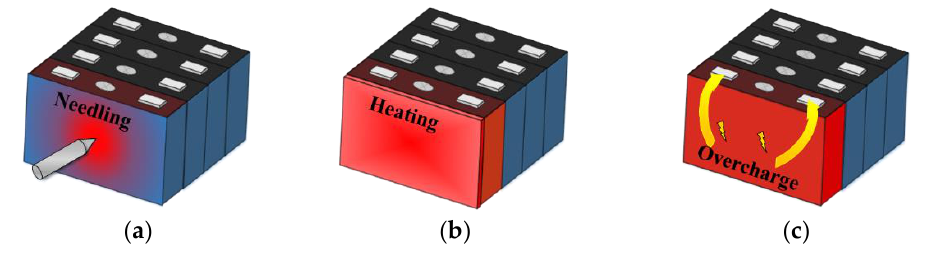
Figure 3. Trigger methods: ( a ) needling; ( b ) heating; ( c ) overcharge.